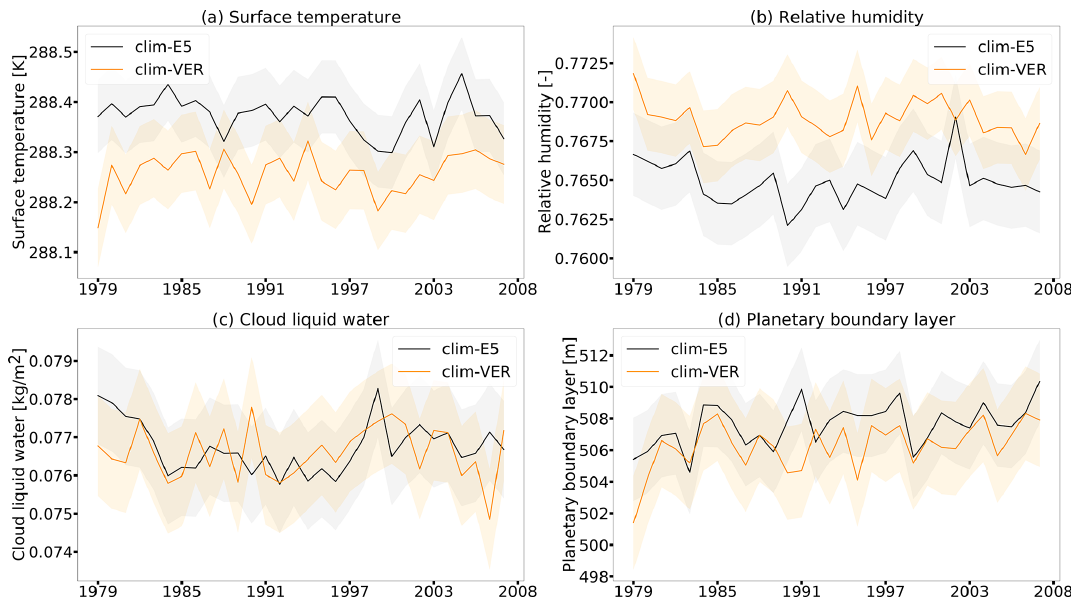
Figure 2. Global mean properties and the uncertainty range (95% confidence interval in shaded) of the climatology simulations with E5VDIFF (clim-E5) and with VERTEX (clim-VER) for the period